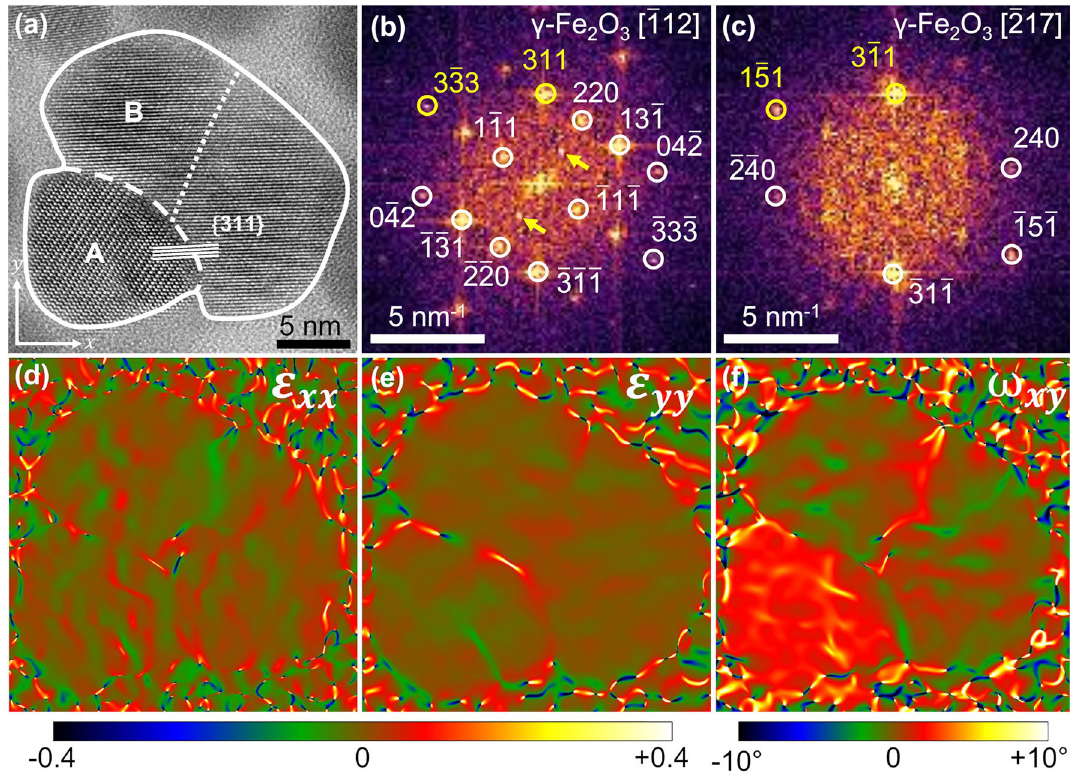
Figure 4. ( a ) HRTEM image of a double-core IONF. The outline of the IONF, the interface between the two cores, and the interface between individual nanocrystals within the larger core are indicated by a solid, dashed and dotted line, respectively. Panels ( b ) and ( c ) show local FFTs of the cores labeled A and B in ( a ), respectively. The spots marked by yellow circles were used for GPA. Reflections associated with the ordering of vacancies are marked by arrows in ( b ). The strain field components ε xx and ε yy and the rigid rotation field ω xy determined by GPA are shown in panels ( d ), ( e ) and ( f ), respectively. The coordinate system is provided in the lower left corner of panel ( a